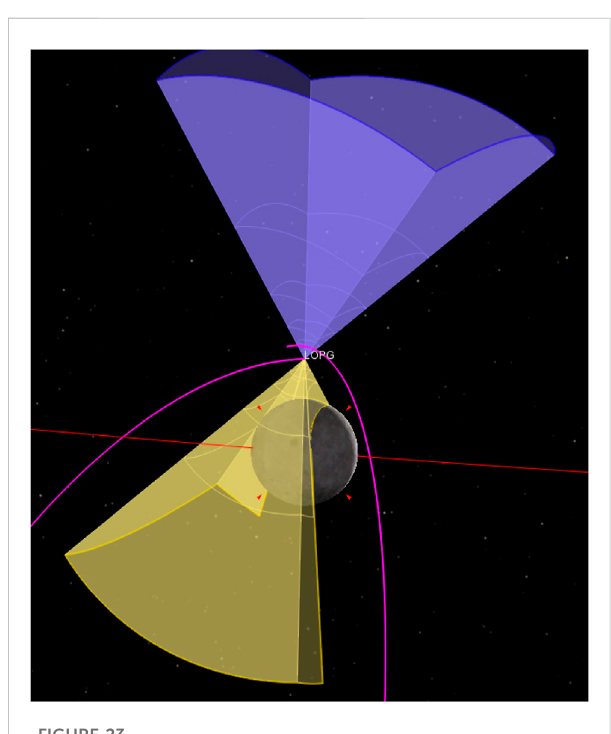
FIGURE 23 cENPD instantaneous FOVs of the two oppositely directed sensor heads, near periapsis. Purple FOV: pristine energetic particle fl ux. Yellow FOV: Moon albedo energetic particle fl ux. The magenta line is the track of the center of the FOV along the Gateway